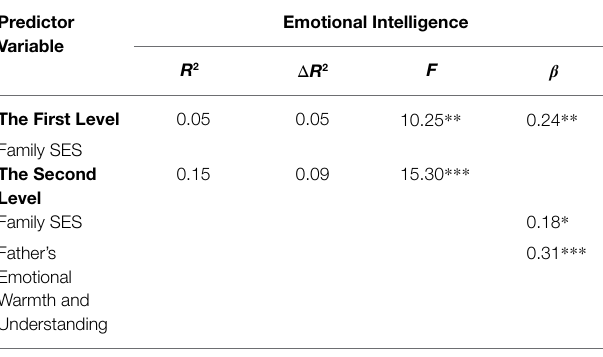
TABLE 7 | Regression analysis of Jingzhou primary school students’ emotional intelligence on family socioeconomic status, father’s emotional warmth, and understanding.